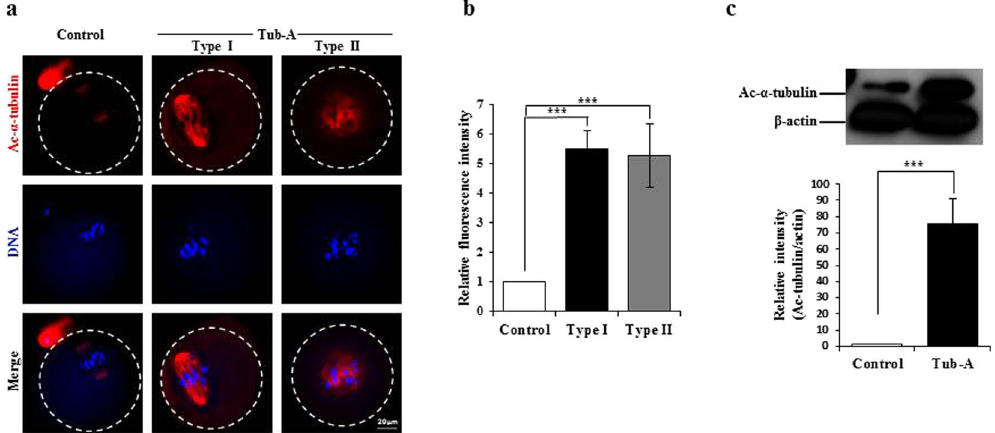
Figure 3. Increased acetylation of α -tubulin in Tub-A treated oocytes. ( a ) Representative images of acetylated α -tubulin in control and Tub-A treated oocytes. Red: acetylated α -tubulin; Grey: chromosome. ( b ) Quantification of the data shown in ( a ). Experiments were conducted three times, and over 50 oocytes were analysed for each group. ( c ) Western blot analysis showing the increased acetylation of α -tubulin in the Tub-A treatment group compared to the control group. Actin served as a loading control throughout. Band intensities were calculated using the ImageJ software; ratio of acetylated α -tubulin/actin expression was normalised, and values are indicated. *** p <